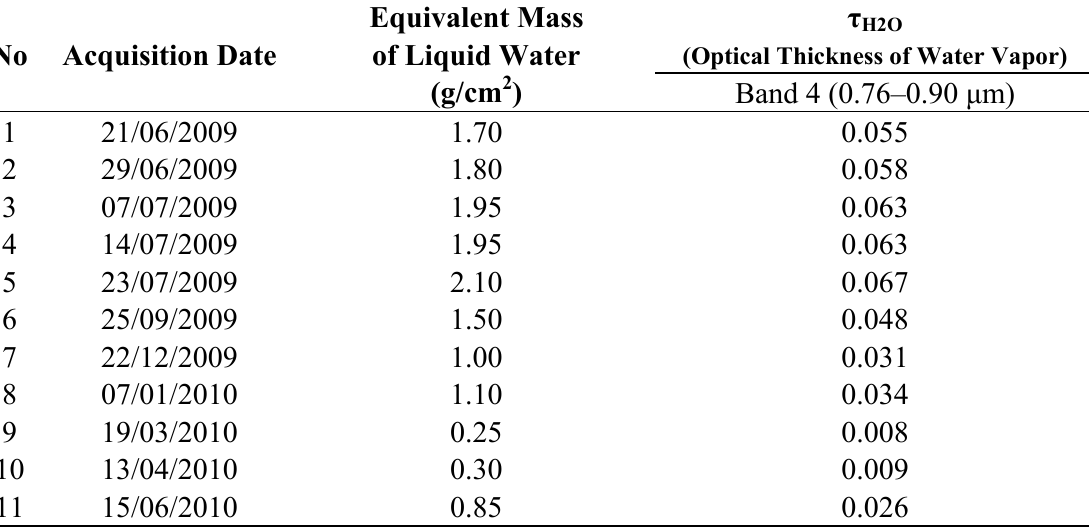
Table 3. Equivalent mass of liquid water for the satellite images used in this